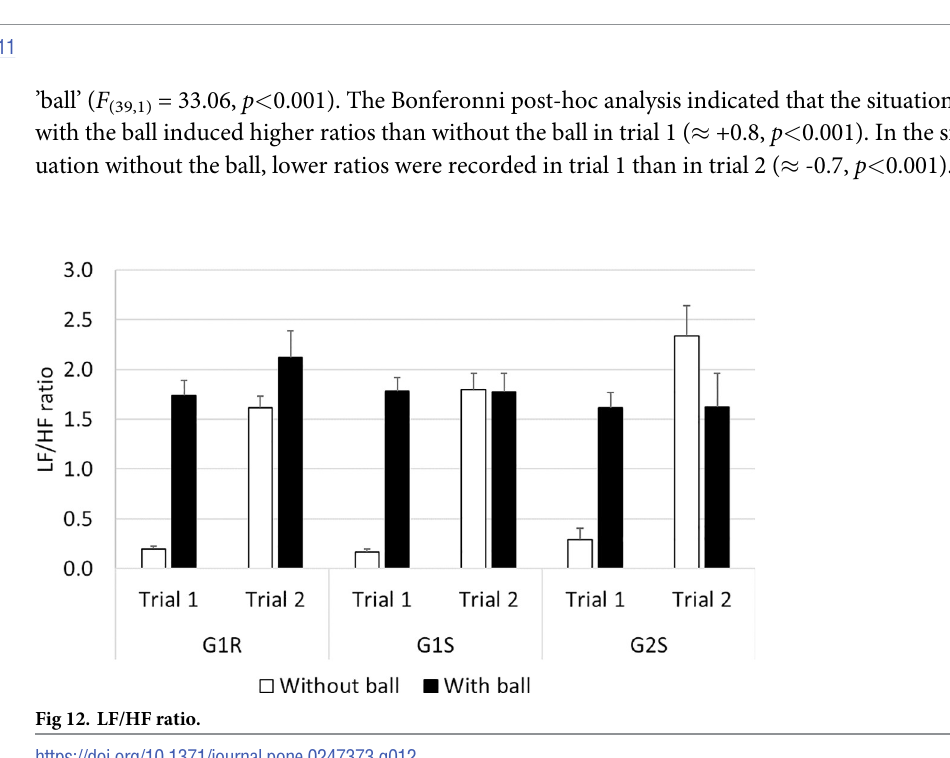
PLOS ONE | https://doi.org/10.1371/journal.pone.0247373 February 19,